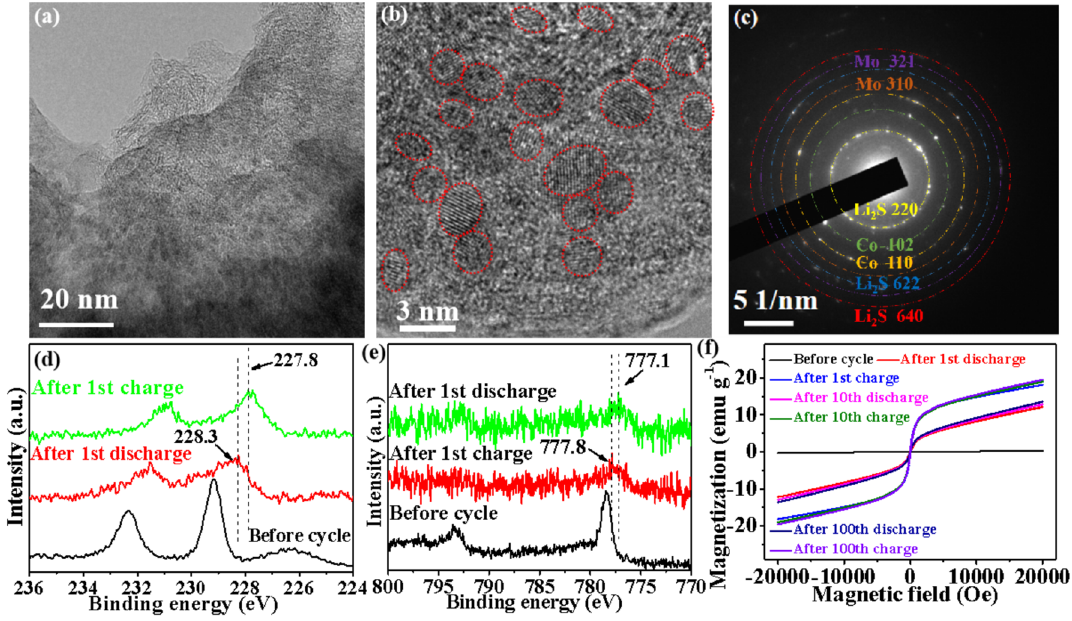
Fig. 5 Ex situ testing of CoMoS 2 /C-II electrodes. a , b TEM images after discharging to 0.01 V and c corresponding SAED pattern. XPS spectra of d Mo 3 d , e Co 2 p . f Magnetic hysteresis